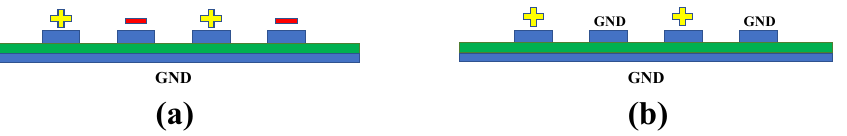
Figure 8. Illustration of the ( a ) differential and ( b ) single-ended electrode configurations, highlighting positive, negative, and ground (GND)